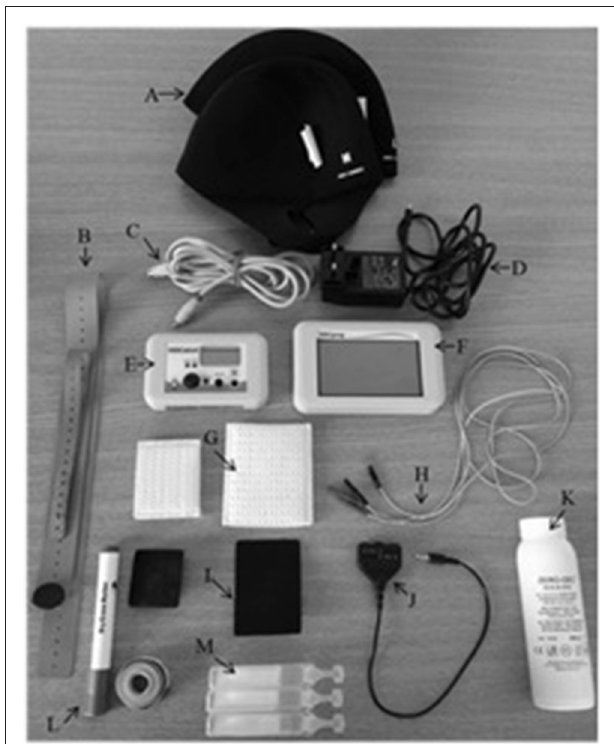
FIGURE 1 | tDCS equipment for the HDC Kit. (A) Neoprene swimming caps for securing electrodes, (B) straps for securing electrodes, (C) programmer/stimulator connector cable, (D) power supply, (E) tDCS stimulator (batteries inside), (F) tDCS stimulator parameter programmer, (G) sponge holding bags, (H) electrode cables (red—anodal; black—cathodal), (I) rubber electrodes, (J) cable connector, (K) conductive EEG gel, (L) measuring equipment (washable pen and measuring tape), (M) saline (20ml pouches for easy application). Not all tDCS kits come with a separate stimulator and parameter